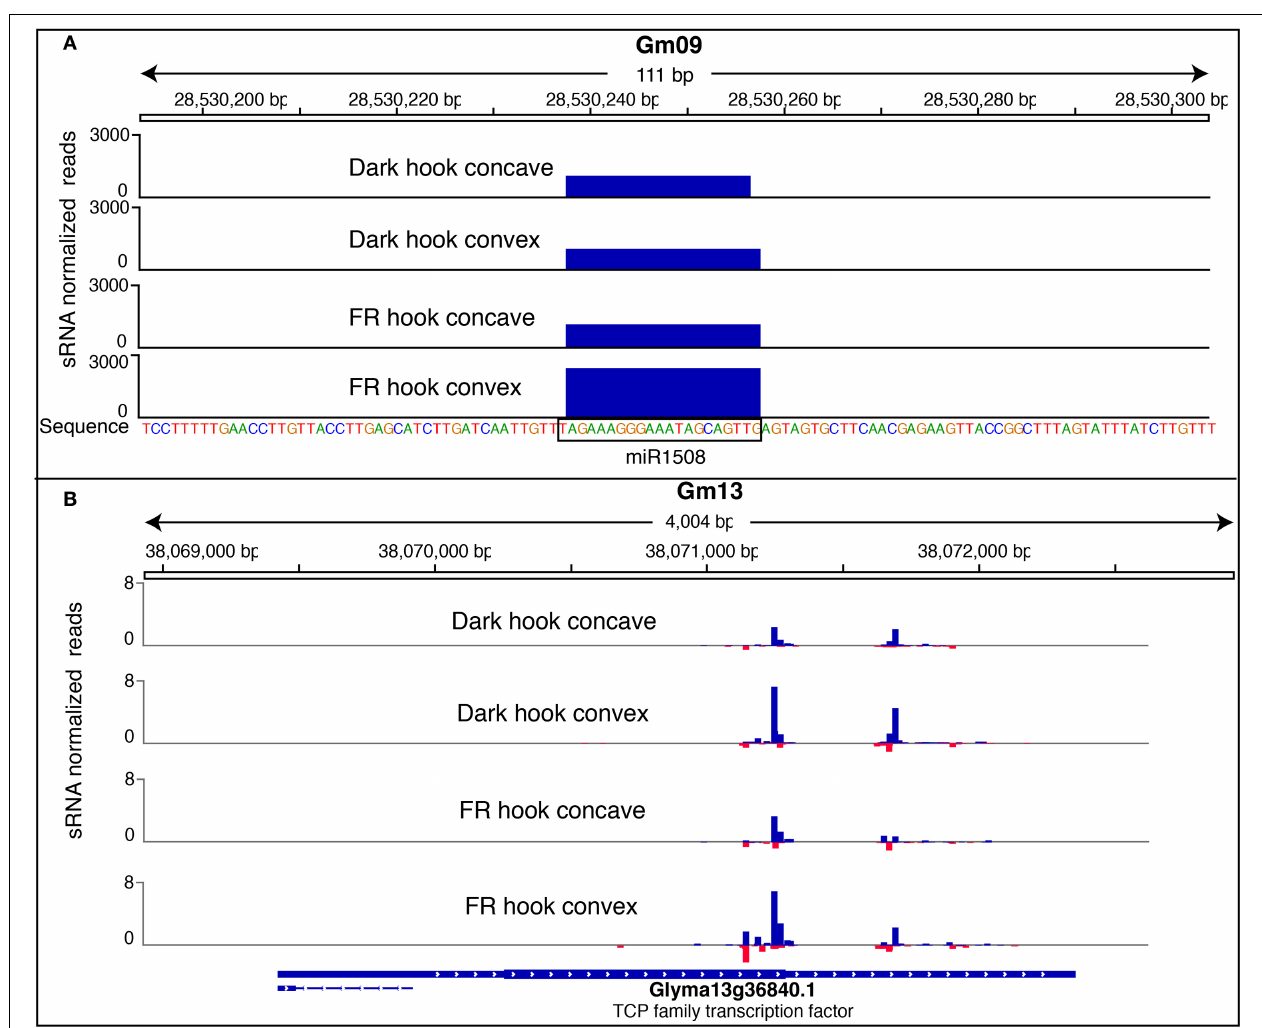
FIGURE 6 | Graphs showing the small RNA reads mapping to a miRNA block (A) and siRNA block (B). (A) A hook-convex specific FRc-responsive miRNA miR1508 was shown as an example. The mature miR1508 reads was mappedtoagenomicregioninGm09.Eachsamplewasrepresentedasatrack, whiletheY-axisofthetrackrepresentstheRPMnormalizedweightedcountsof the sRNA reads. (B) A siRNA block with higher expression level in hook convex